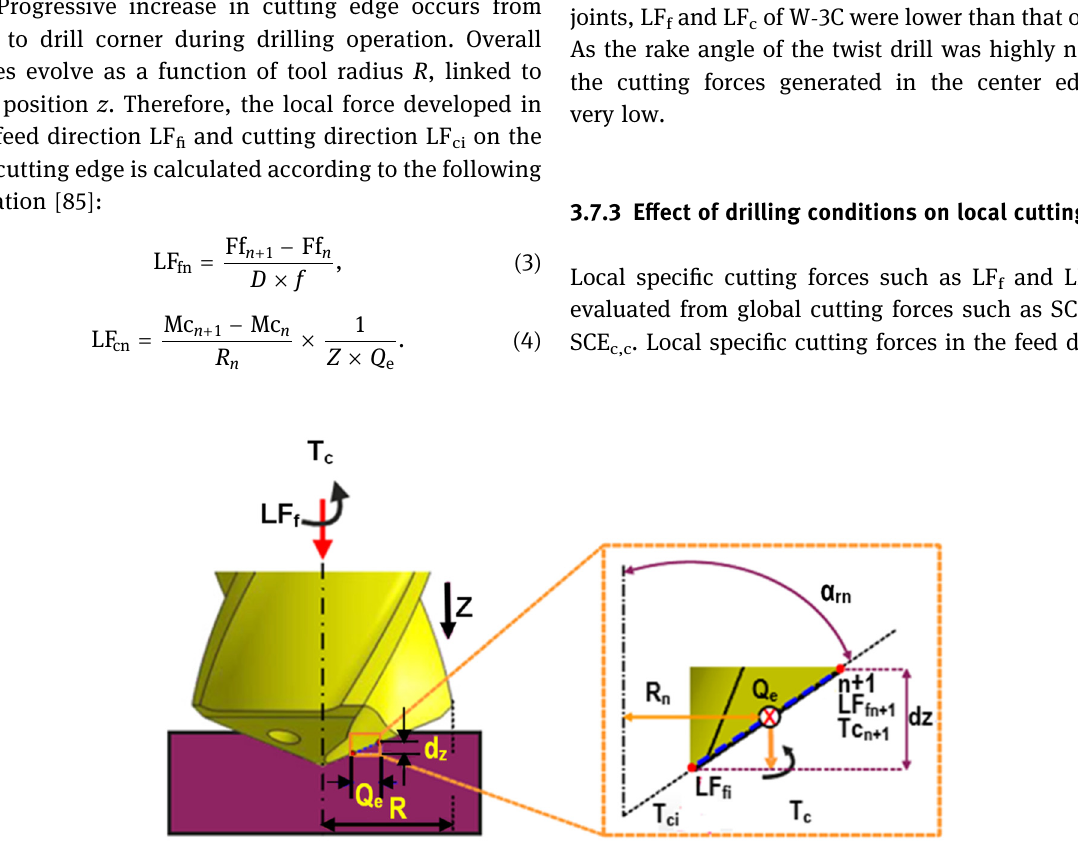
Figure 10: Various forces developed during drill tip